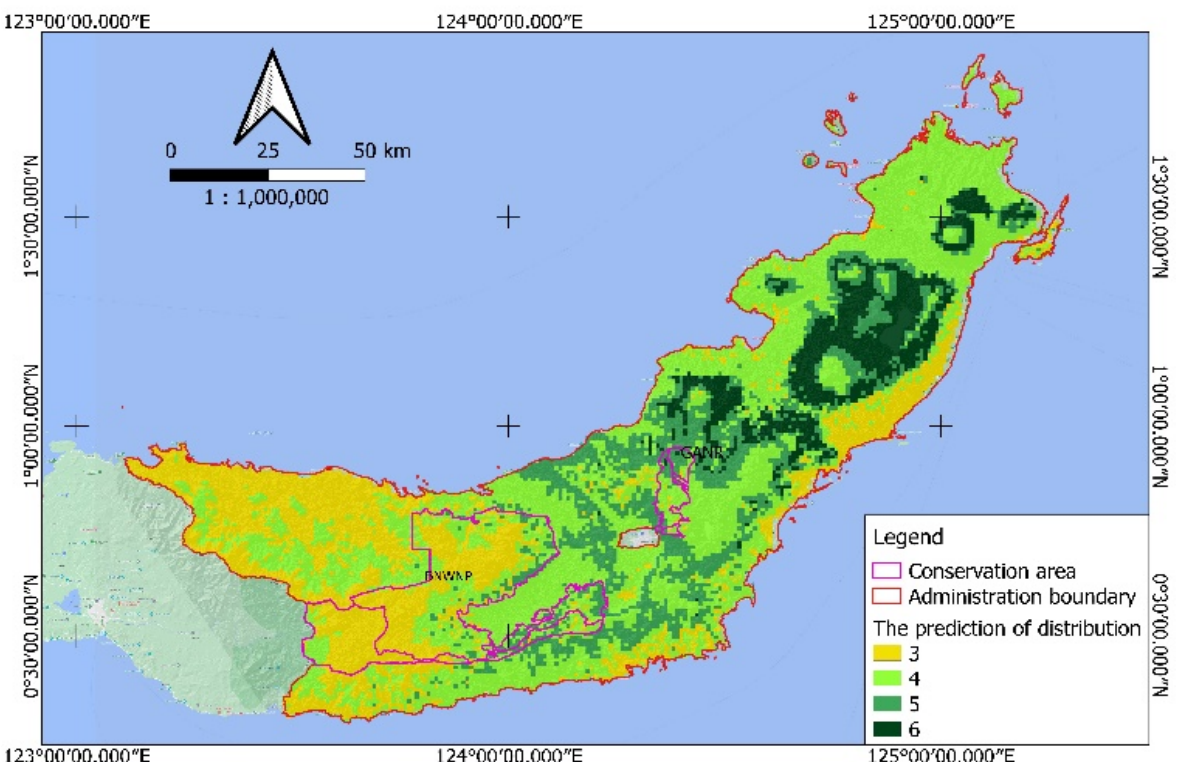
Figure 7. Distribution prediction patterns of Magnolia spp. in North Sulawesi, with the number representing habitat suitability, with 3 indicating the least suitable habitat and 6 representing the most